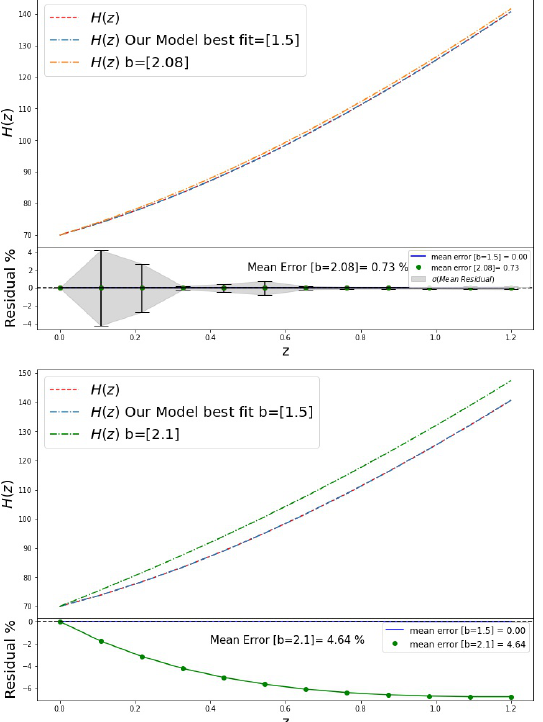
Figure 1. ( Up ): Comparison of H ( z ) between Λ CDM values and our model’s values with best fit value of b = 1.505 and for b = 2.08, which corresponds to the maximum value of b for the residual error as ≤ 1%. The error bars in the residue plot panel (and the grey highlighted zone), correspond to the standard deviation in the respective redshift bin, computed from all the b values mentioned in the main text. ( Down ): The same comparison, but for b = 2.11, which corresponds to the error limit of ≤ 5%. The bottom panel in both the plots shows the corresponding residual plot.